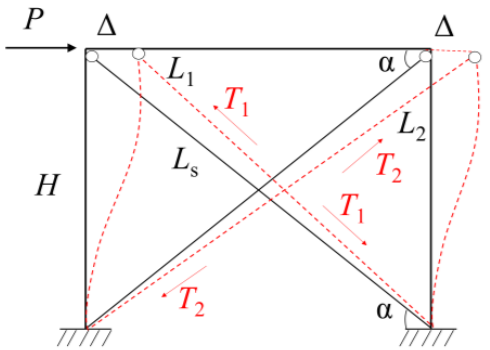
Figure 2. Deformation of a structural system under horizontal load.